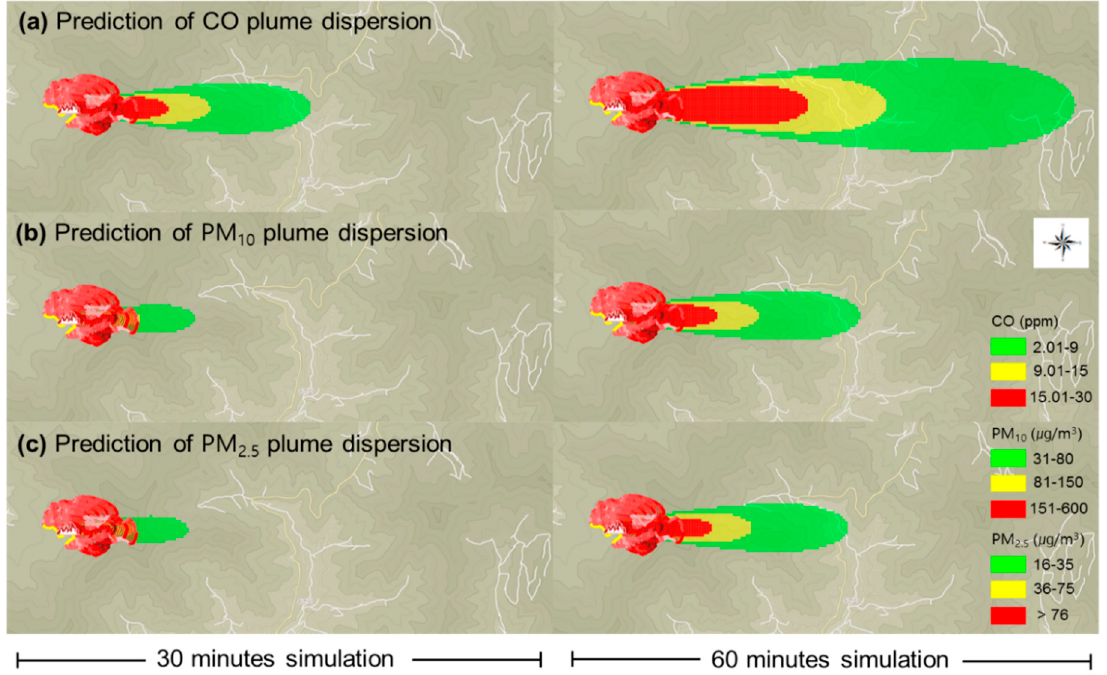
Figure 6. Predicteddispersionsof( a )CO,( b )PM 10 , and( c )PM 2.5 plumeconcentrationcontoursafter30min Figure 6. Predicted dispersions of ( a ) CO, ( b ) PM 10 , and ( c ) PM 2.5 plume concentration contours after and 60 min of smoke simulations. Both fires and predicted CO, PM 10 , and PM 2.5 surface concentrations are 30 minutes and 60 minutes of smoke simulations. Both fires and predicted CO, PM 10 , and PM 2.5 surface shown. PM 2.5 and PM 10 are fine (<2.5 µ m) and coarse (<10 µ m) particulate matter, concentrations are shown. PM 2.5 and PM 10 are fine (<2.5 µm) and coarse (<10 µm) particulate matter, respectively.